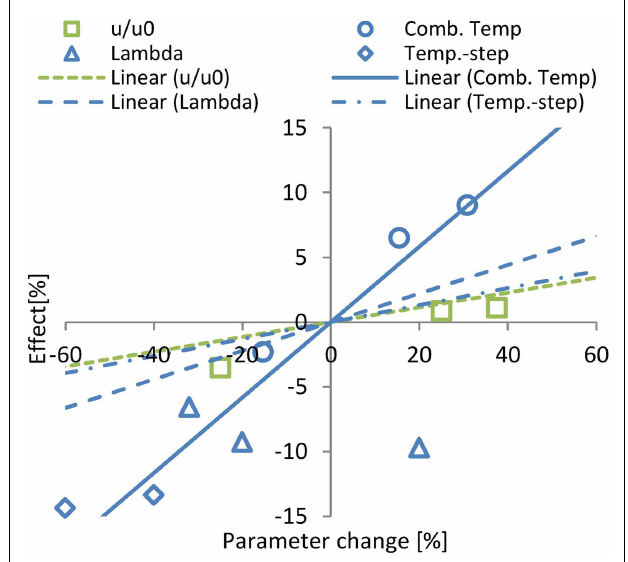
FIGURE 4 | Result of operating parameter sensitivity analysis showing the effect of internal parameters on agglomeration temperature . u / u 0 = fluidization velocity; Comb.Temp, combustion temperature during the fuel feed phase; Lambda, excess air ratio;Temp.step, gradient of the temperature ramp;